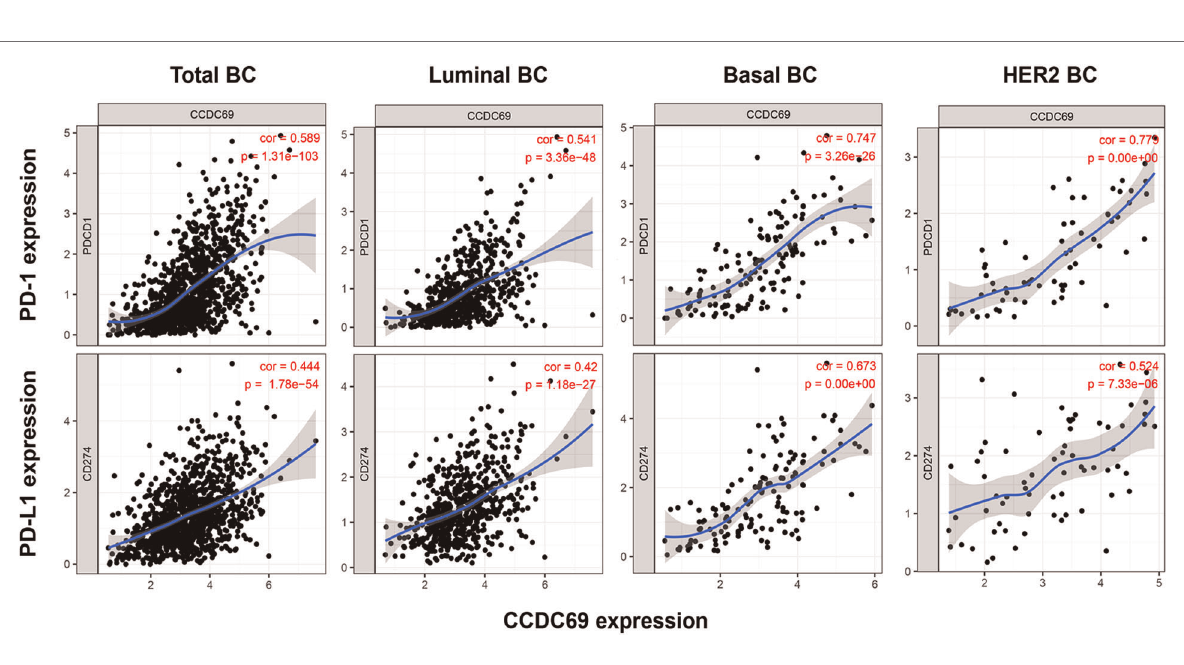
FIGURE 8 The expression levels of PD-1 and PD-L1 were decreased in BC with low expression of CDCC69. The relationship between CCDC69 expression and PD-1 and PD-L1 expression in various BC subtypes was evaluated by